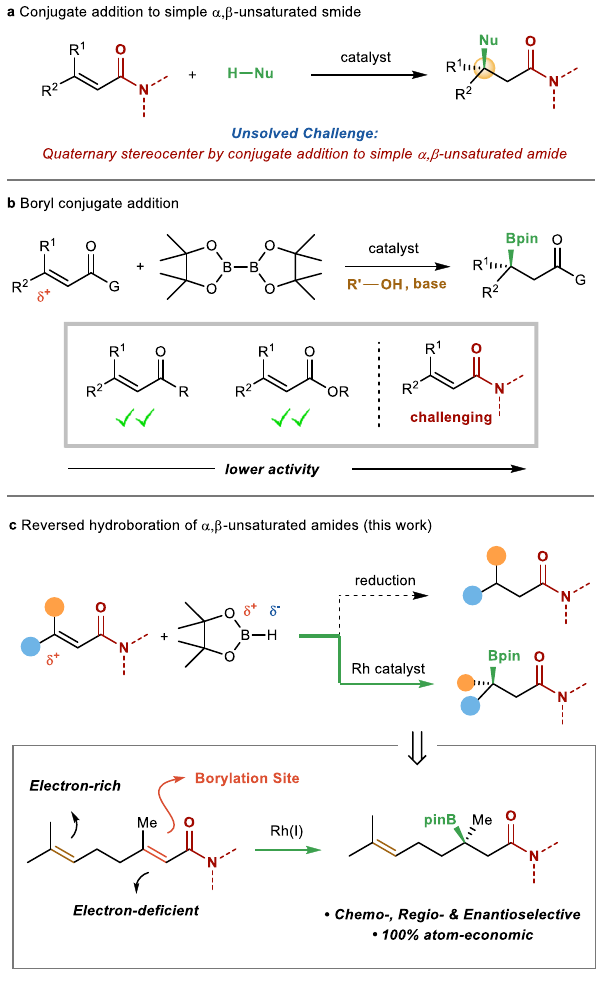
Fig. 1 Catalytic hydroboration of alkenes. a Conjugate addition to α , β - unsaturated amides. b Boryl conjugate addition. c Reversed hydroboration of α , β -unsaturated